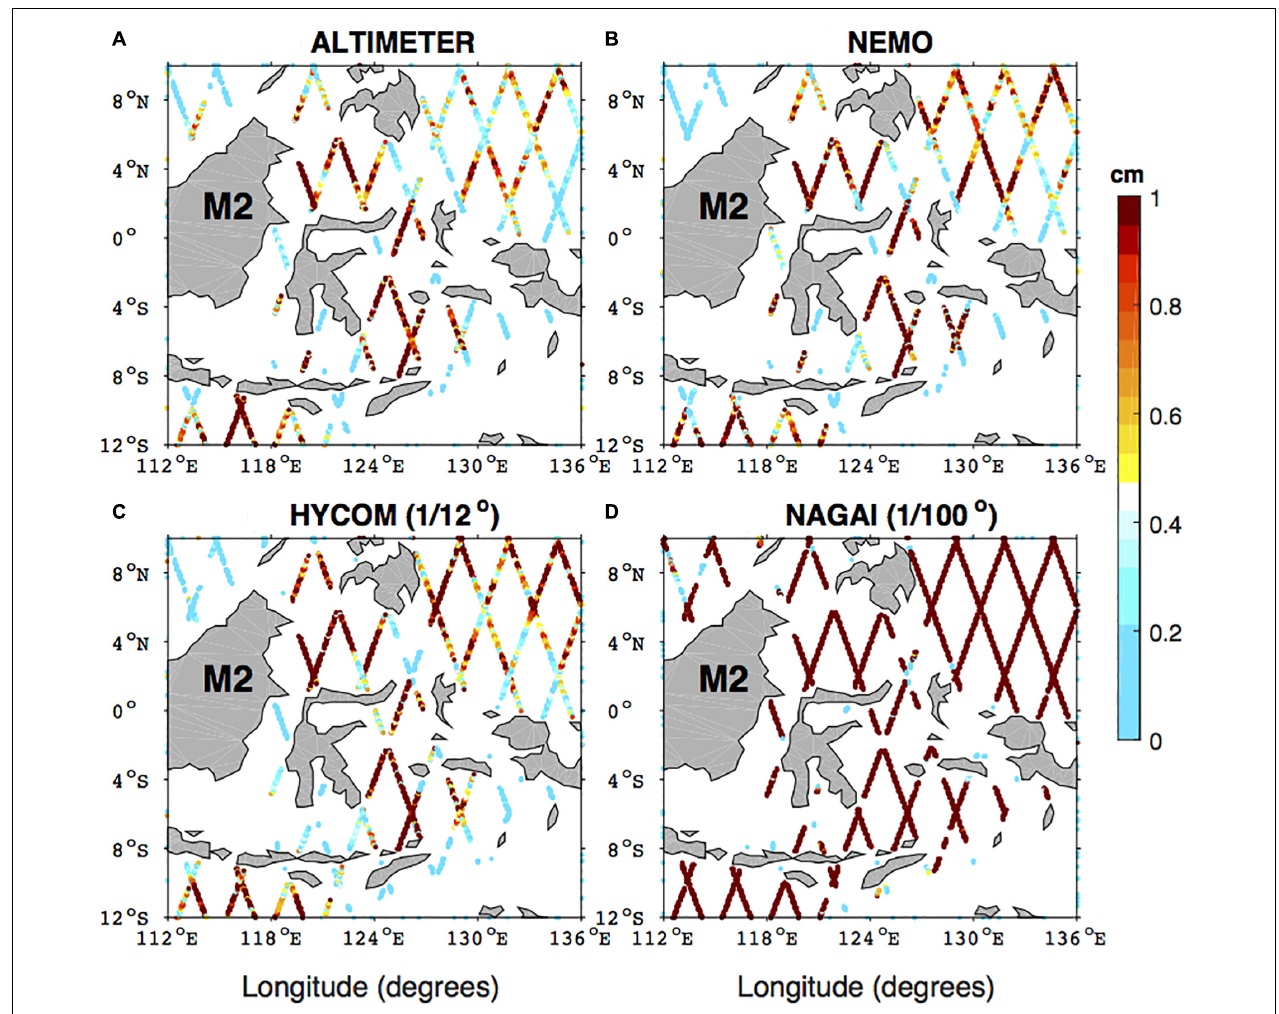
FIGURE 12 | The baroclinic tides (cm) from (A) along-track TOPEX/Poseidon and Jason satellite altimeter data (1992–2009) (B) the NEMO 1/12 ◦ INDESO model configuration (Nugroho et al., 2017) and (C) the HYCOM 1/12 ◦ model configuration (Ansong et al., 2015) and (D) the MITgcm (1/100 ◦ , Nagai and Hibiya, 2015). Details of the approach used to extract baroclinic tides from the HYCOM output and along-track altimeter data are provided in Shriver et al. (2012). Model output are interpolated to the altimeter tracks. For models and altimeter output, spatial band-pass filtering along the altimeter tracks is used to extract the M2 internal tide signals with wavelengths in the 50–400 km range. Only locations with sea floor depth greater than 1500 m are plotted (Figure from Ansong et al.,